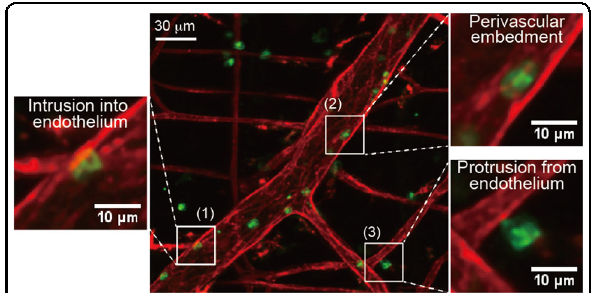
Fig. 2 Visualization of the substeps of neutrophil extravasation by two-photon microscopy. Analysis of neutrophil in fi ltration visualized from three-dimensional two-photon images of anti-CD31 antibody-labeled blood vessels in mouse cremaster upon stimulation with N -formylmethionyl-leucyl-phenylalanine: (1) intrusion into the endothelium, in which the neutrophil cell body started to penetrate the endothelial cell layer; (2) most of the neutrophil cell body then was colocalized within the CD31-labeled endothelial cell layer; (3) as the fi nal step, the tailing edge of the extravasating neutrophil was attached. Please see Video